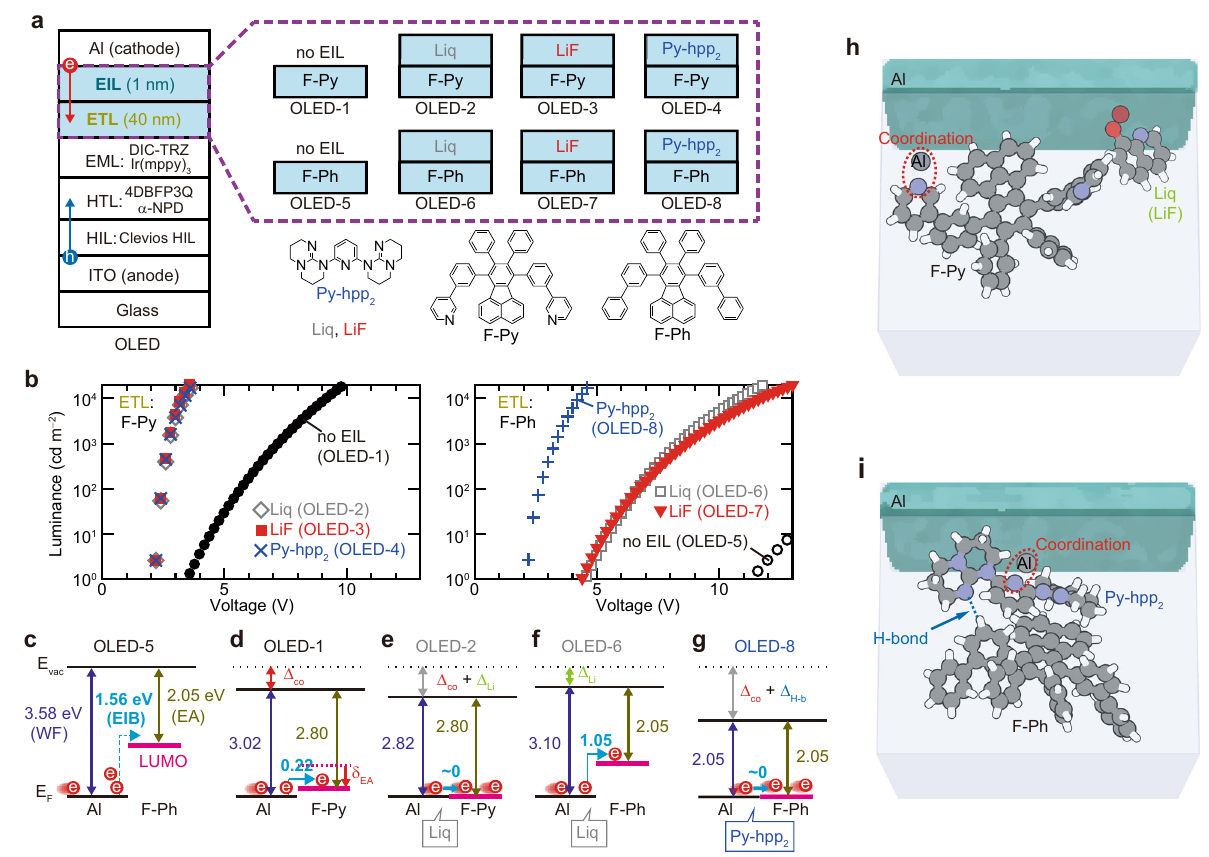
Fig. 1 Characteristics of OLEDs with different EIL/ETL combinations. a Multilayer structure of an OLED, chemical structure of the materials used in the ETL and EIL, and schematic illustrations of their combination. b Luminance – voltage characteristics of green phosphorescent OLEDs prepared using various EIL/ETL combinations. c – g Summary of the energy diagrams around each cathode estimated from UPS and LEIPS, where E F and E vac represent the Fermi and vacuum levels, respectively. h , i Schematic illustrations of nitrogen-induced interactions around the cathode such as the coordination reaction with diffused Al atoms and the formation of H-bonds between Py-hpp 2 and the material used in the